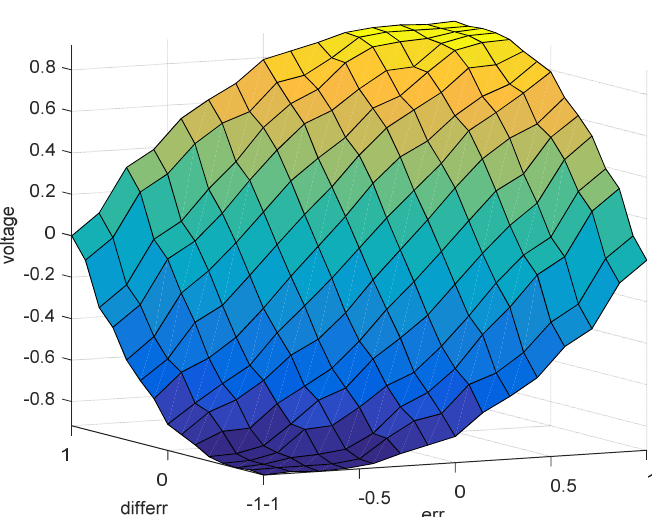
Figure 3. Membership functions of input and output variables.